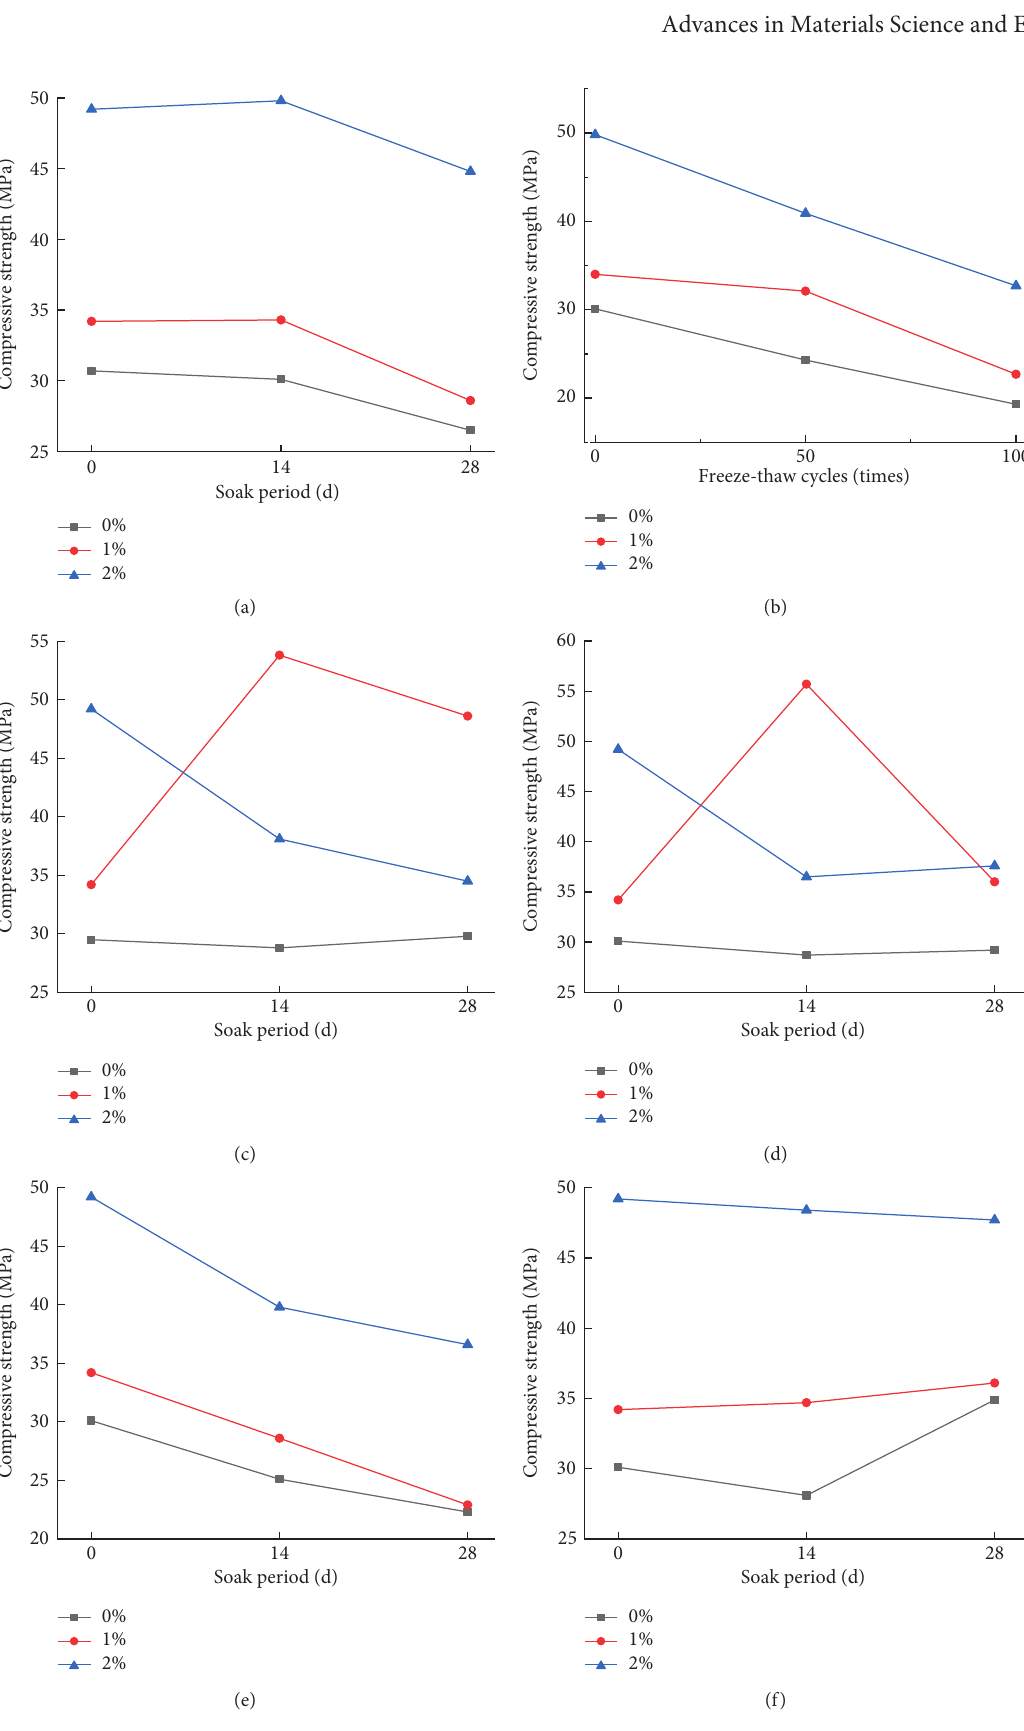
Figure 16: Axial compressive strength of specimen soaked in solution. (a) Specimens soaked in water. (b) Freeze-thaw specimen. (c) Specimens soaked in NaCl solution. (d) Specimens soaked in Na 2 SO 4 solution. (e) Specimens soaked in H 2 SO 4 solution. (f) Specimens soaked in NaOH